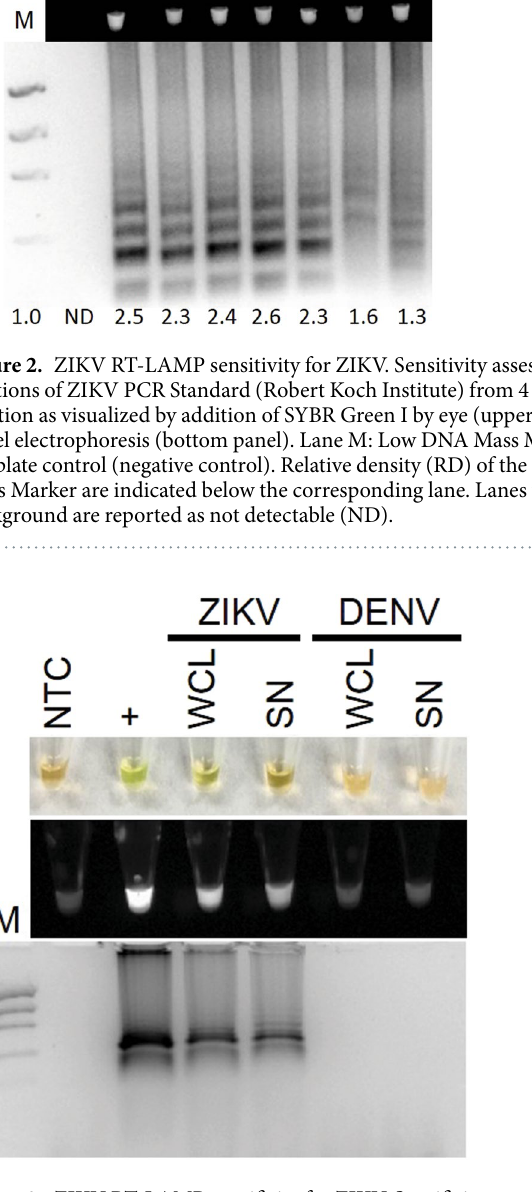
Figure 3. ZIKV RT-LAMP specificity for ZIKV. Specificity assessment of ZIKV RT-LAMP in ZIKV or DENV infected whole cell lysates (WCL) or cell culture supernatants (SN) as visualized by the addition of SYBR Green I by eye (upper panel), green fluorescence (middle panel), or gel electrophoresis (bottom panel). Lane M: Low DNA Mass Marker (ThermoFisher Scientific); NTC: No template control (negative control); + : ZIKV PCR Standard (Robert Koch Institute; positive